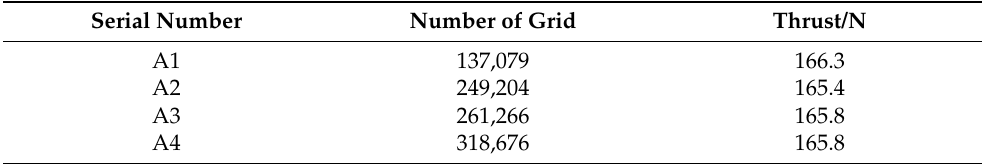
Table 4. The different thrust under four grid